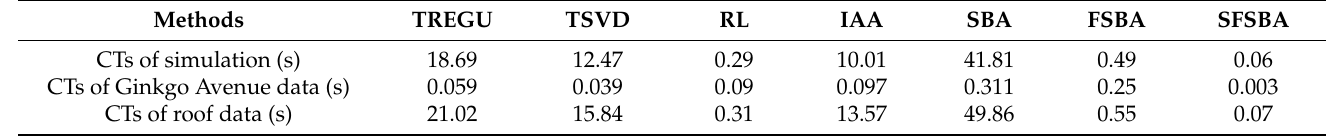
Table 9. Computing time of different